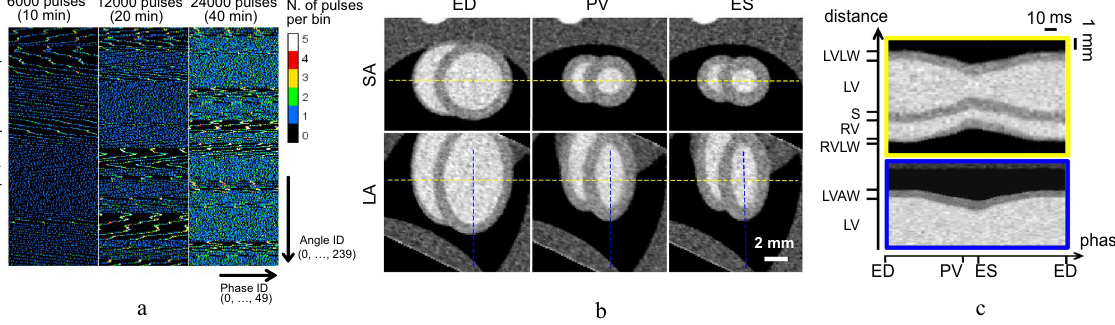
Figure 3. ( a ) 2D histograms showing the distribution of the X-ray pulses on the phase/angle diagram for the simulated acquisition of the dynamic phantom. Histograms are binned in 50 cardiac phase bins and 240 angular bins. Dark areas show missing data due to transitory coherence between the cardiac motion and the X-ray pulse sequence. ( b ) Reoriented short-axis and long-axis images of the mouse heart (only three of the 50 reconstructed phases are shown) obtained by iterative reconstruction from the sequence of 12000 pulses. ( c ) M-mode-like image of the reoriented heart, obtained along the dashed lines shown in ( b ) for all the 50 reconstructed time frames. For all images, the voxel size is 100 μ m and the temporal binning (frame duration) is 3 ms, calculated as the mean R-R interval divided by the number of reconstructed frames per cycle. ED: end-diastole; PV: peak myocardial velocity; ES: end-systole; SA: short axis; LA: long axis; LV: left ventricle; LVLW: left ventricle lateral wall; LVAW: left ventricle apical wall; RV: right ventricle; RVLW: right ventricle lateral wall; S: septum. FBP: filtered backprojection; SIRT: simultaneous iterative reconstruction